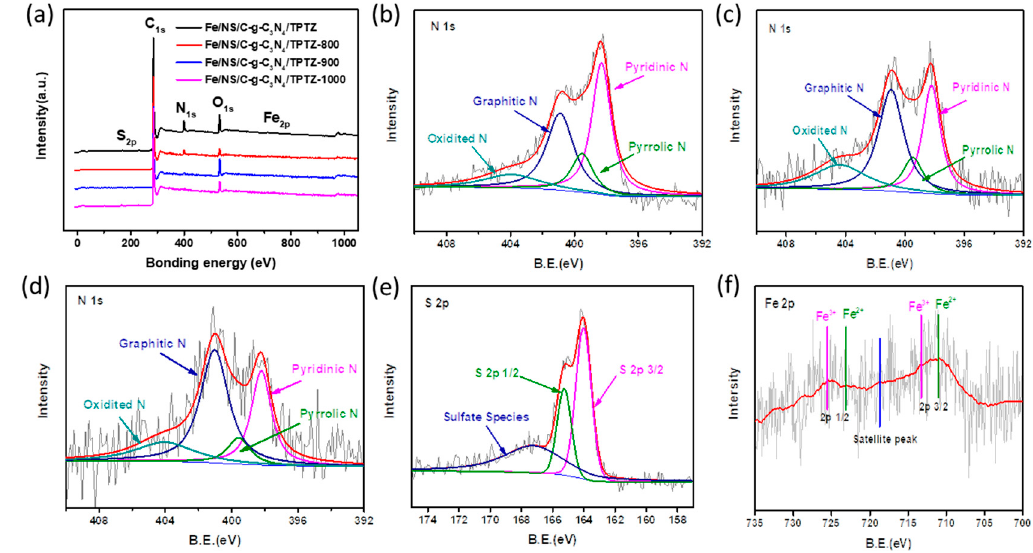
Figure 6. ( a ) XPS survey spectra of Fe/NS/C ‐ g ‐ C 3 N 4 /TPTZ and Fe/NS/C ‐ g ‐ C 3 N 4 /TPTZ ‐ T (T = 800, 900, 1000); high ‐ resolution N 1s spectra of ( b ) Fe/NS/C ‐ g ‐ C 3 N 4 /TPTZ ‐ 800, ( c ) Fe/NS/C ‐ g ‐ C 3 N 4 /TPTZ ‐